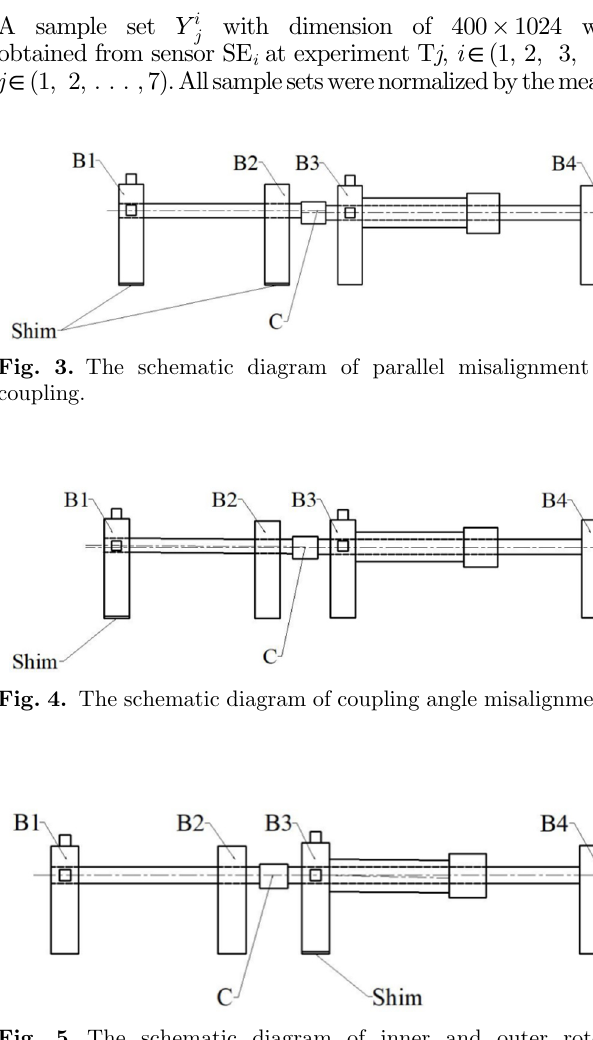
Fig. 5. The schematic diagram of inner and outer rotors misalignment.